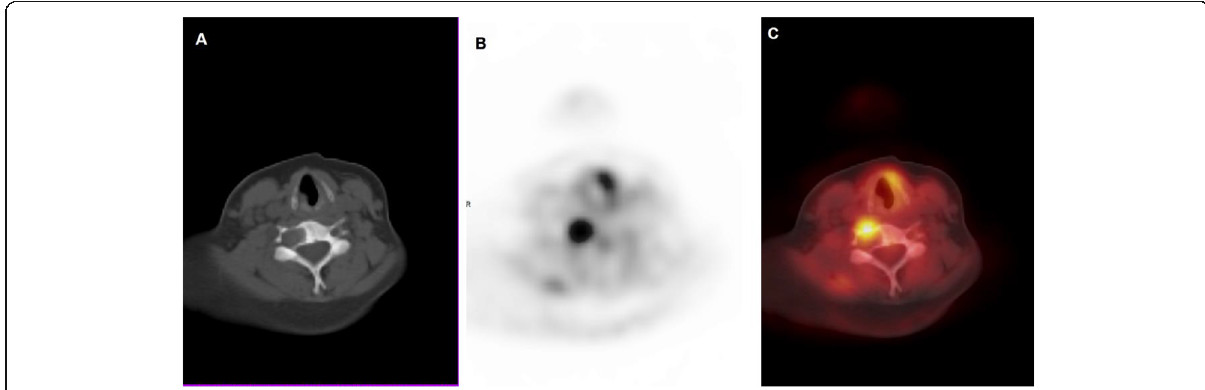
Fig. 4 18 F-FDG PET/CT: A axial computed tomography image showed a lytic lesion in the right side of C6 vertebral body, B axial PET images, and C fused PET/CT axial image showed FDG-avid lytic lesion in the right side of C6 vertebral